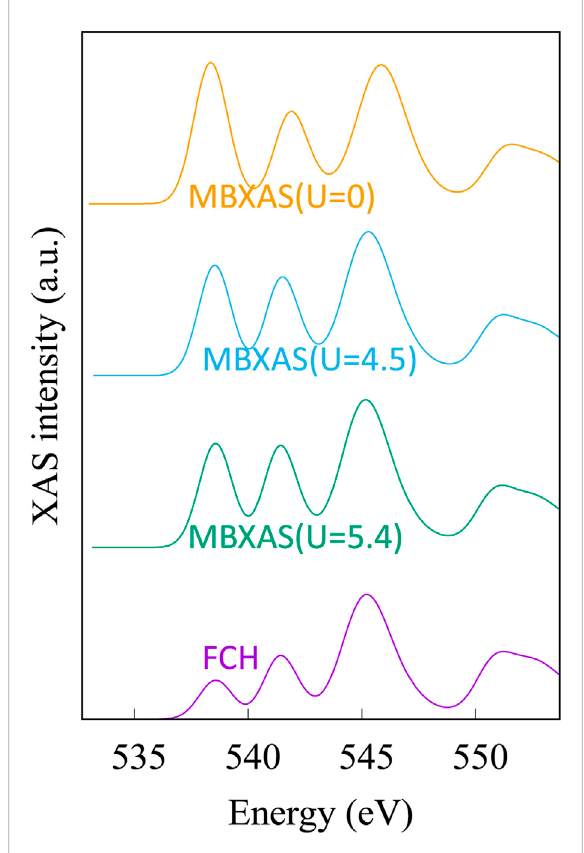
FIGURE 10 Simulated XAS plots for oxygen K -edge of CeO 2 . In the “ FCH ” plot, the dipole matrix element is obtained with the single-particle treatment presented in Eq. 4. This plot is obtained from KS-DFT calculations using a Hubbard parameter of U = 5.4 eV. The three MBXAS plots, which correspond to different values of Hubbard U (namely, 5.4, 4.5, and 0 eV), use the many-body expression of Eq. 5 to calculate the dipole